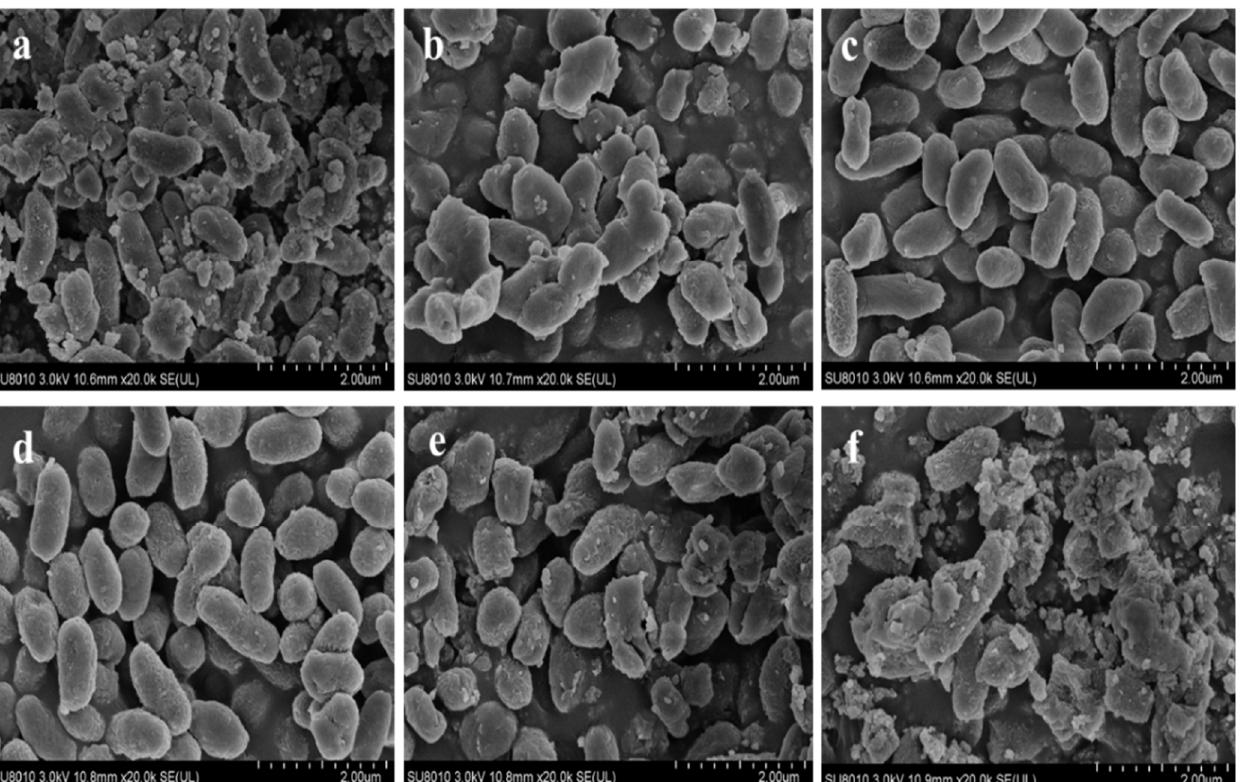
Figure 2. Morphological of V. brasiliensis cells after cultivation in different NaCl concentrations. ( a ) Cells cultured in without NaCl medium; ( b ) cells cultured in 1% NaCl medium; ( c ) cells cultured in 2% NaCl medium (optimal growth NaCl content of V. brasiliensis ); ( d ) cells cultured in 3% NaCl medium; ( e ) cells cultured in 5% NaCl medium; ( f ) cells cultured in 7% NaCl medium.